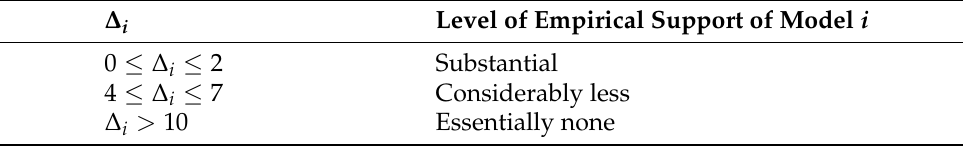
Table 3. Rough rules of thumb for model selection based on AIC